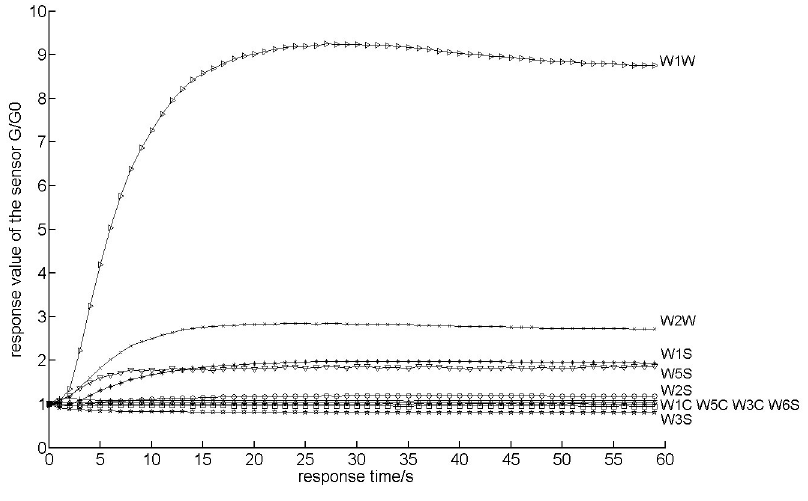
Fig 1. Response of sensor array to tea